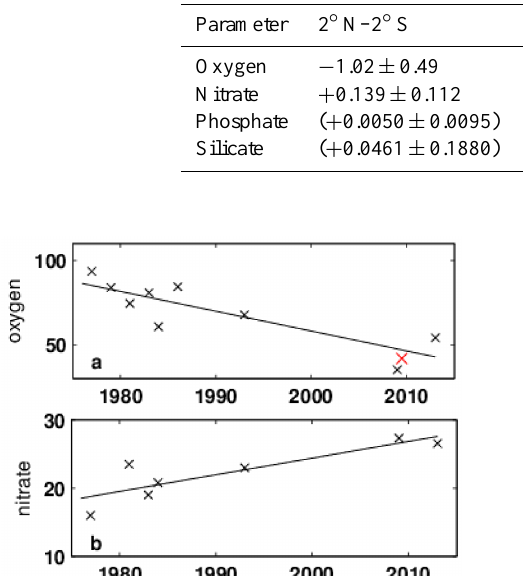
Table 2. Linear trends of solutes in µmolkg − 1 yr − 1 with 95% confidence intervals since 1976 in a 50 to 300m layer for the ocean areas between 84 and 87 ◦ W for 2 ◦ N–2 ◦ S (Fig. 13), 2–5 ◦ , and 5–8 ◦ S. For phosphate at 2 ◦ N–2 ◦ S the years 1978 and 1979 and for silicate at 2–5 ◦ S the year 1976 were removed due to unrealistic low annual mean values. Trends not within the 95% confidence interval are shown in brackets.